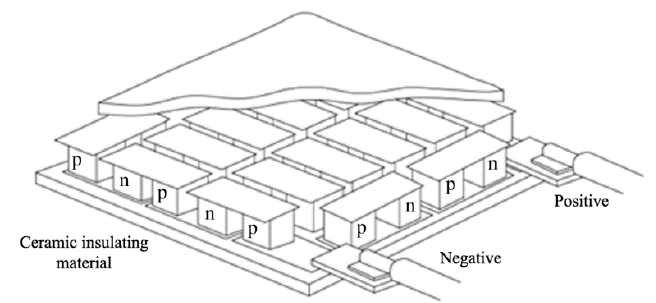
Figure 5. Peltier cells.